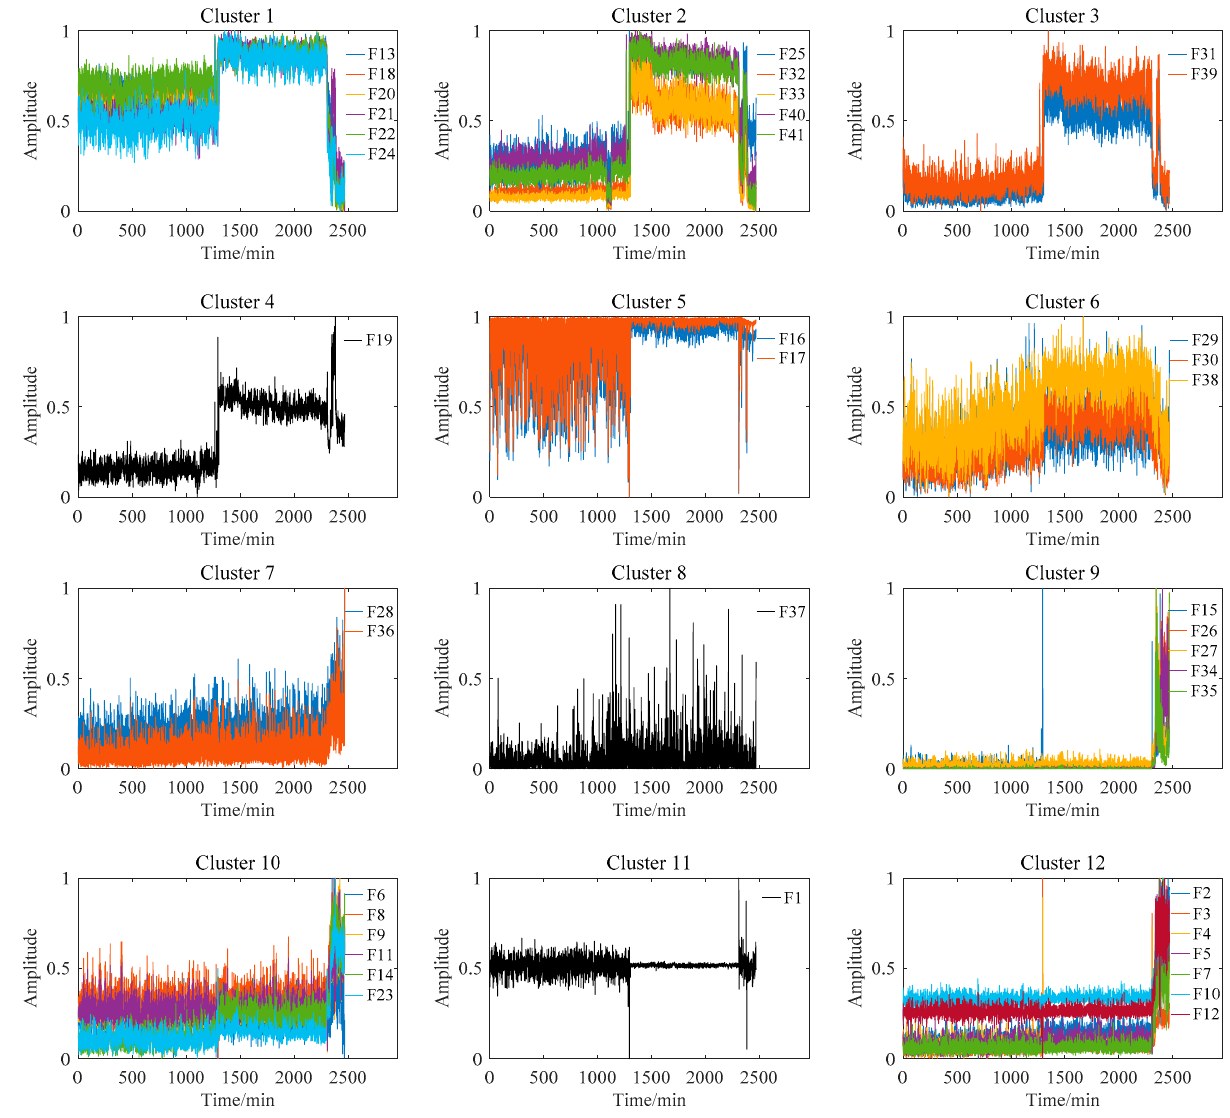
Figure 7. Feature clustering results of bearing B1.